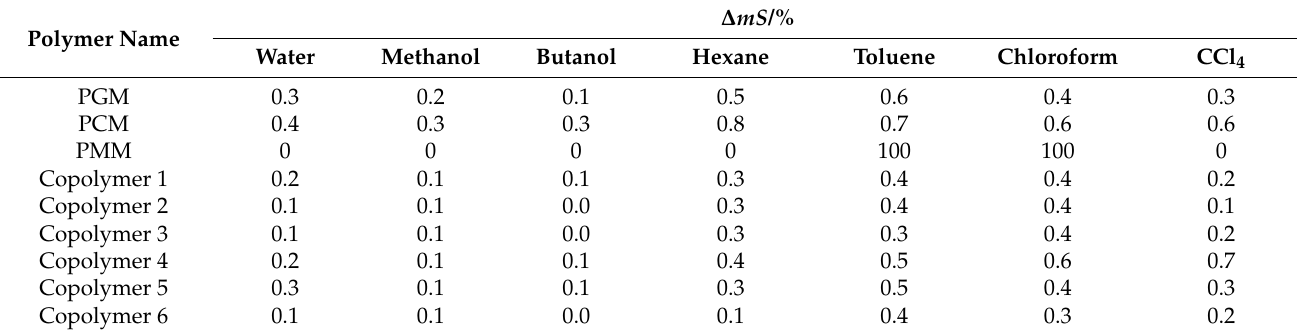
Table 5. Percentage change in mass ( ∆ mS) for samples conditioned at 120 ◦ C (series